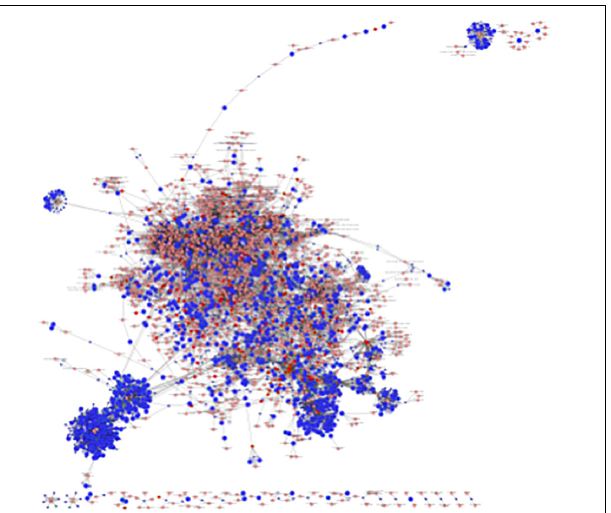
FIGURE 9 | Visual representation of the interactome model. Interaction network of integrated transcriptome and metabolome was analyzed using MetScape 3.1. Dark blue squares represent differentially expressed genes in the placenta dataset; light blue squares represent inferred gene interactions; dark red squares represent significantly changed metabolites in the placenta dataset; light red squares represent inferred metabolite interactions; gray lines represent protein-protein or protein-metabolite